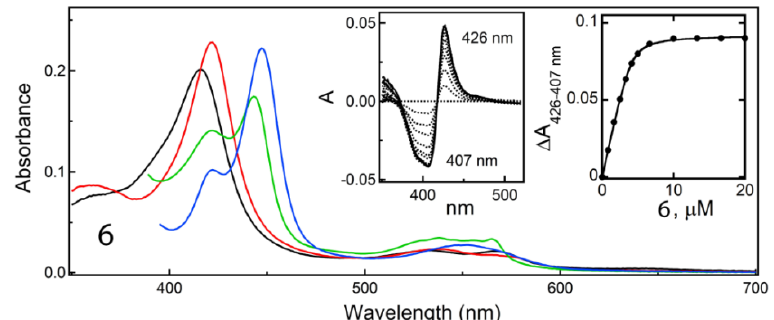
Figure 5. Spectral changes in CYP3A4 induced by compound 6 binding. Absorbance spectra of ferric ligand-free and inhibitor-bound CYP3A4 are in black and red, respectively. Spectra of ferrous ligand-bound CYP3A4 and its CO-adduct are in green and blue, respectively. Left inset shows difference in the spectra recorded during equilibrium titrations; right inset is a titration plot with quadratic fitting. The derived K s value is given in Table 1. It was not possible to determine the inhibitory complex structure because 6 dissociated from CYP3A4 during crystallization.